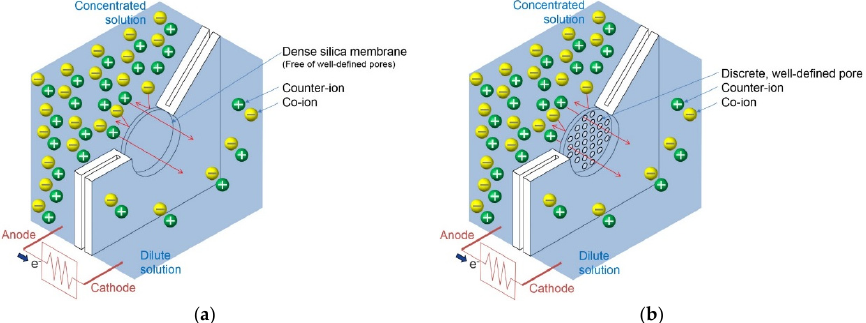
Figure 1. Power generation from concentration gradient by reverse electrodialysis: ( a ) in a dense silica membrane; and ( b ) in a porous membrane. membrane; and ( b ) in a porous